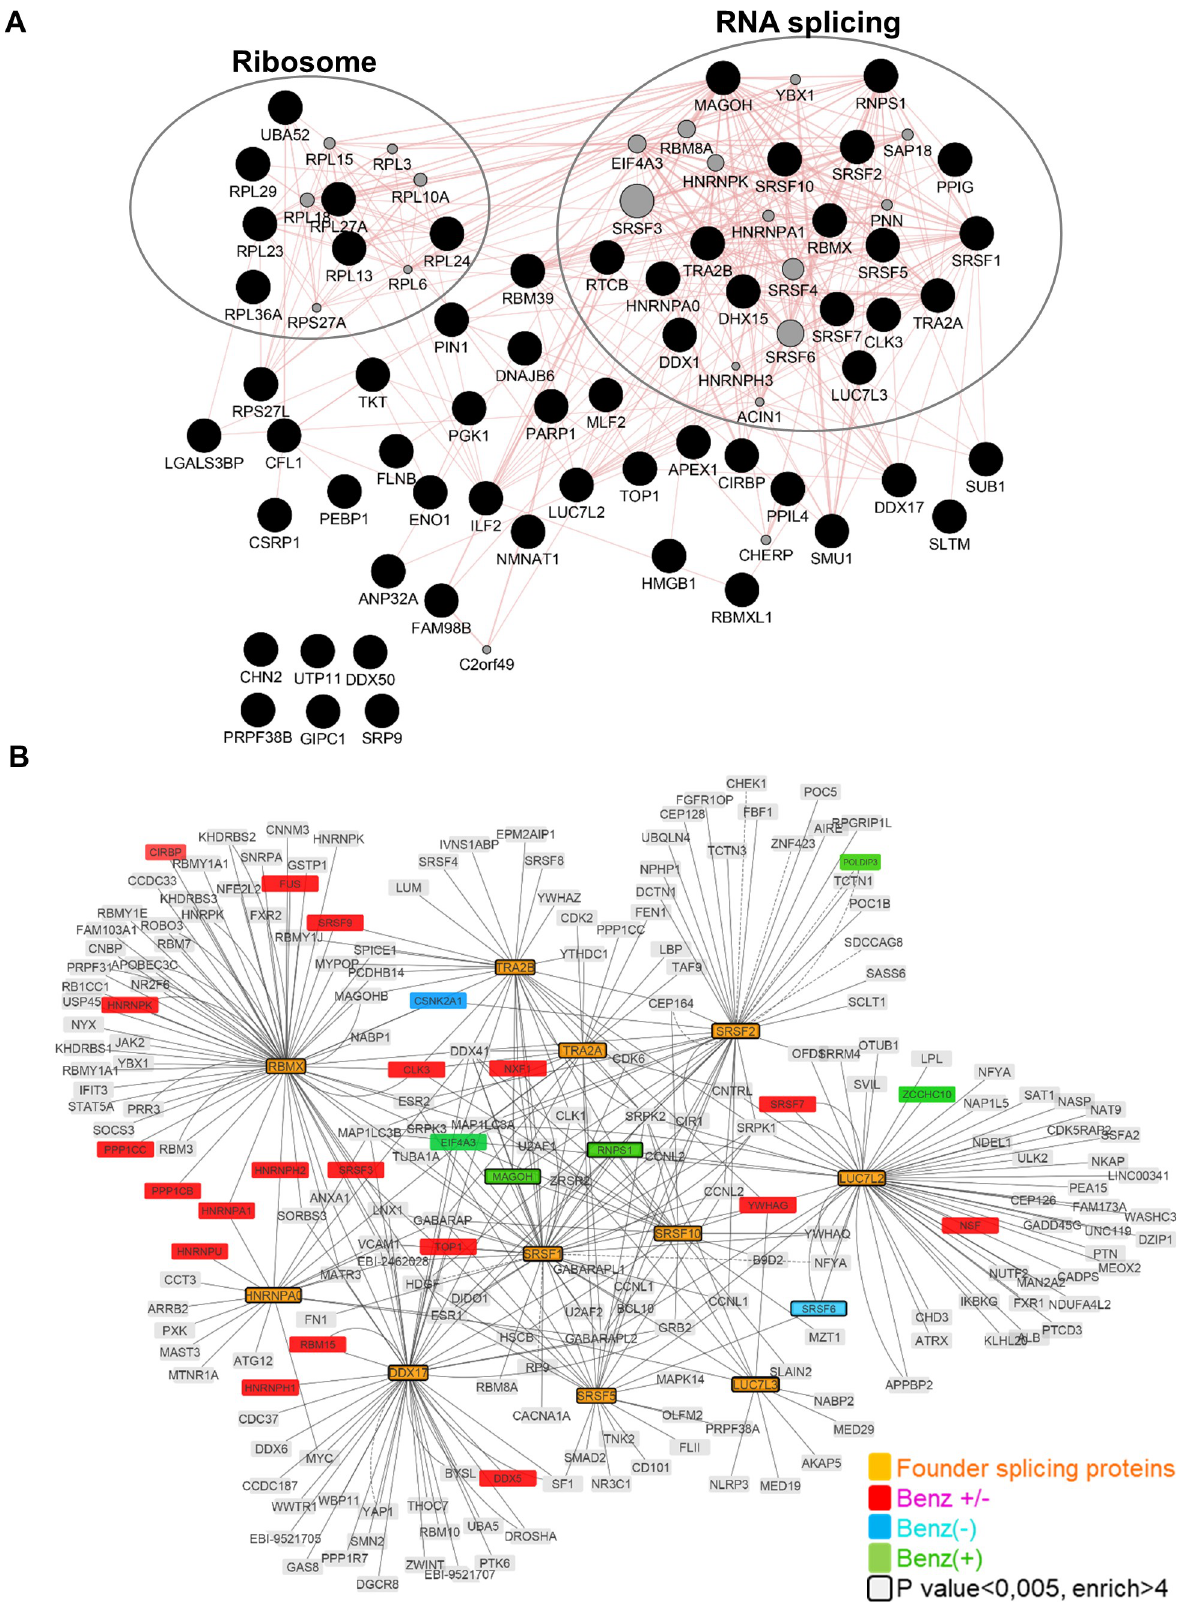
Fig 2. HBc nuclear interactome. (A) Proteins significantly associated to HBc in the presence of Benzonase were analyzed using the Genemania plugin in Cytoscape (3.7.1). Red lines indicate known physical interactions. Missing nodes are indicated by grey circles. (B) Interaction network